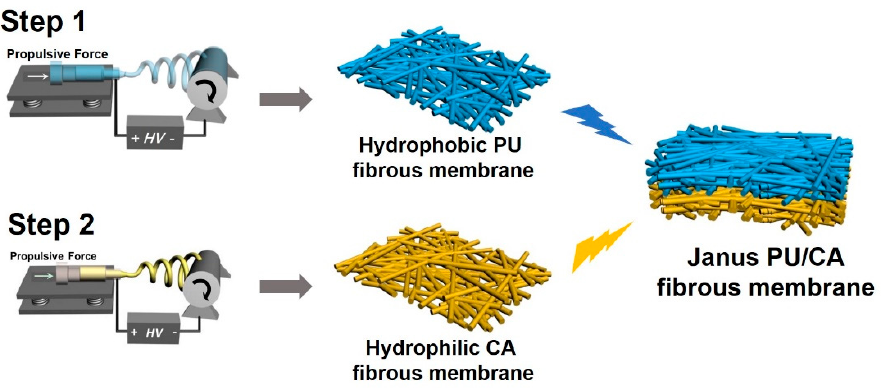
Figure 1. Schematic diagram of the fabrication process of poly[4,4 (cid:48) -methylenebis (phenylisocyanate)-alt- 1,4-butanediol / di(propylene glycol) / plycaprolactone] (PU) / cellulose acetate (CA) Janus fibrous membrane.